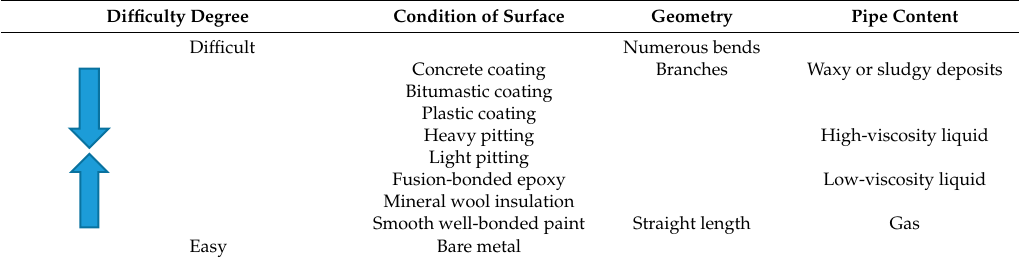
Table 4. Factors affecting guided wave system operation [178].